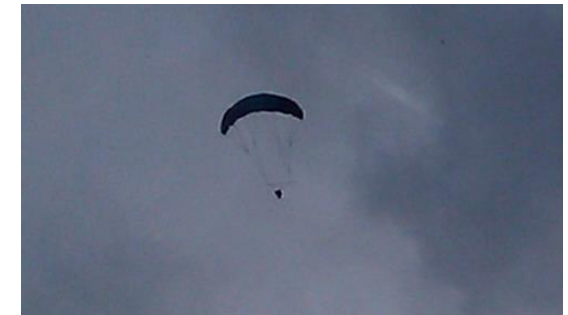
Figure 3. The kite with cradle (side). Photograph by A.K. Helming.